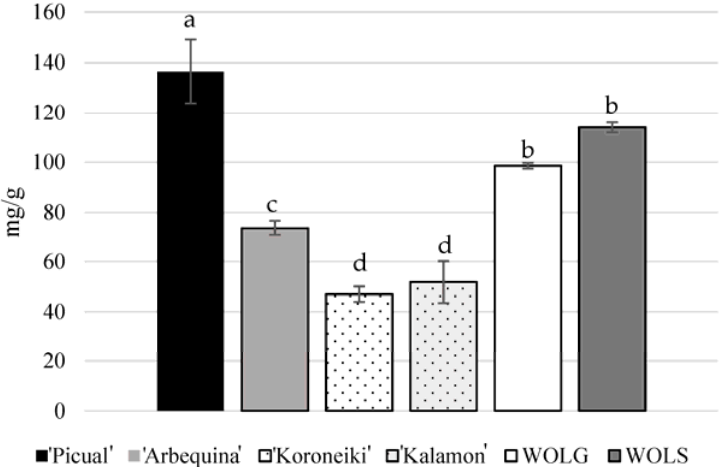
Figure 2. Oleuropein concentration (mg/g) contained in dried olive leaves. WOLG: wild olive leaves ( O.e . spp. oleaster ) from Greece; WOLS: wild olive leaves ( O.e . spp. oleaster ) from Spain. Different lower case letters indicate significant differences among genotypes according to Tukey’s HSD test ( α <